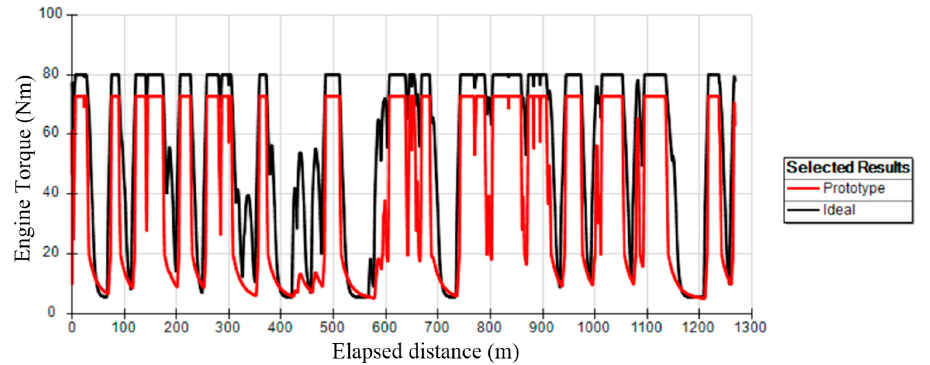
Figure 24. Optimal torque developed along the FSAE Autocross Germany track for the characteristics of the ideal optimized motor and the prototyped motor.